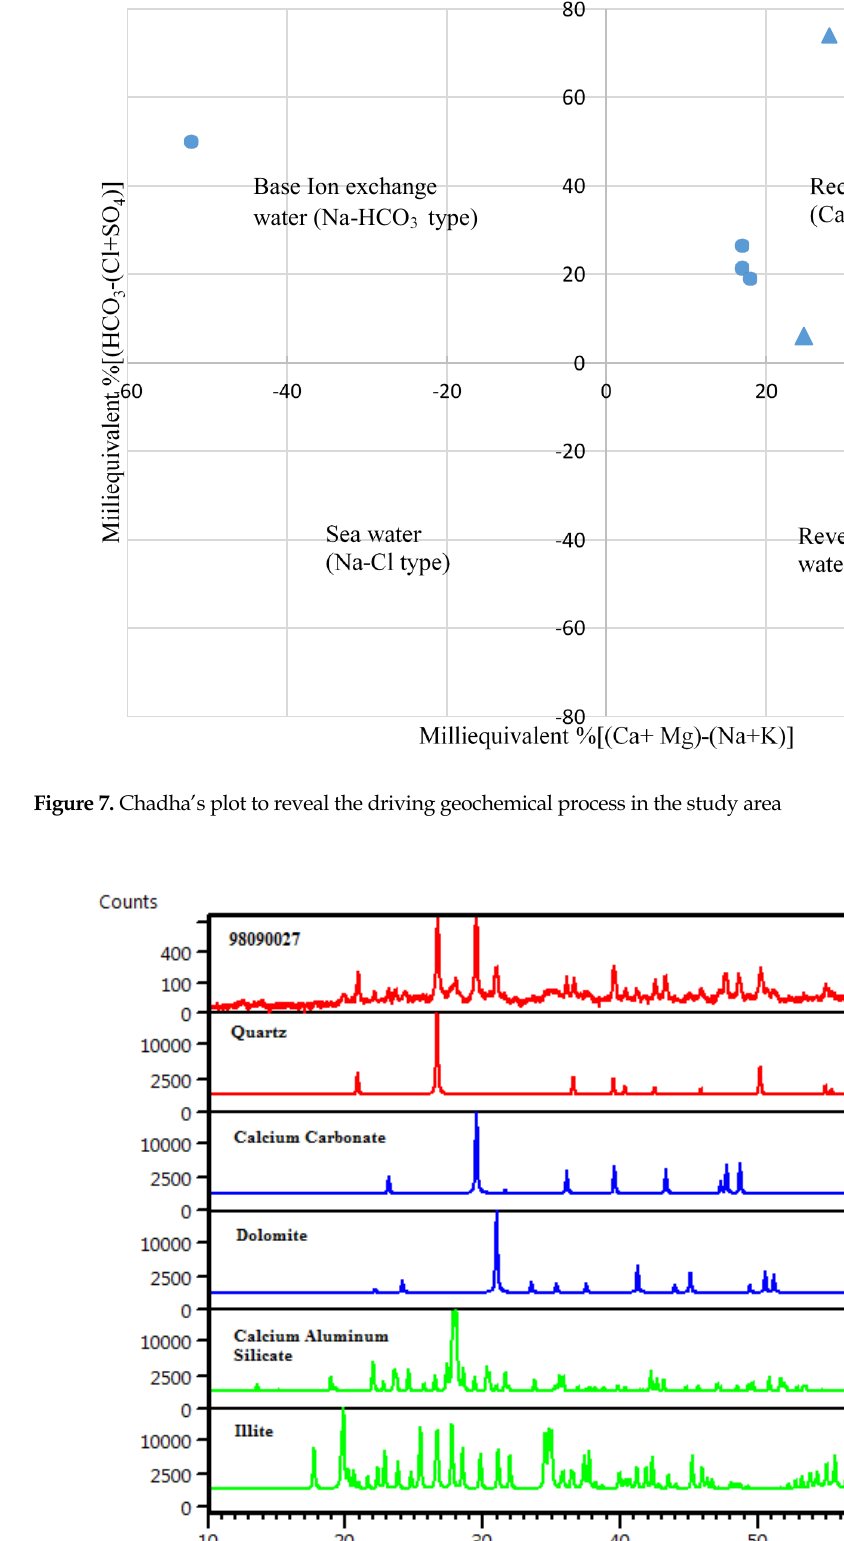
Givi M, et al. Water Quality Assessment of Jajrood River. J Adv Environ Health Res. 2021;